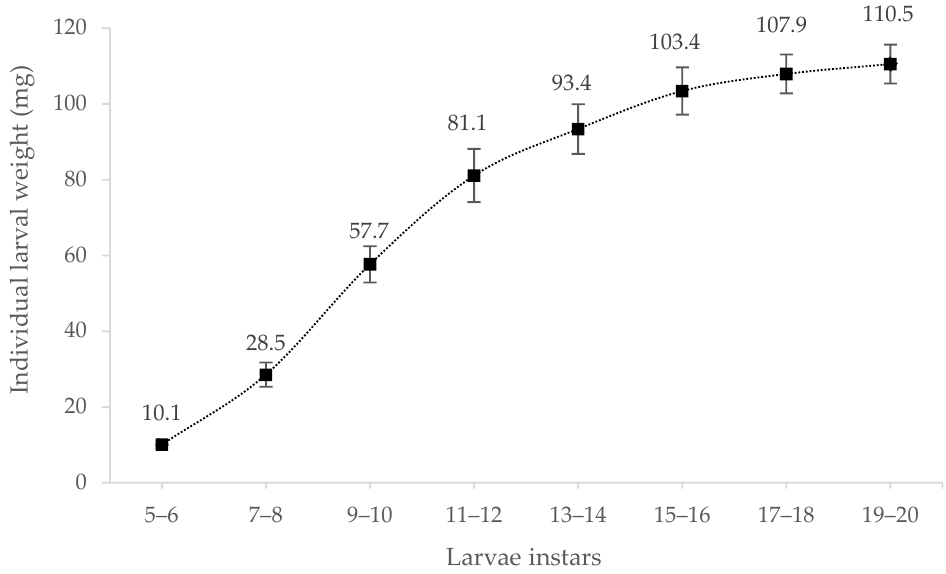
Figure 1. Individual larval weight (mg) of Tenebrio molitor larvae in different instars (5 to 20, n = 100).